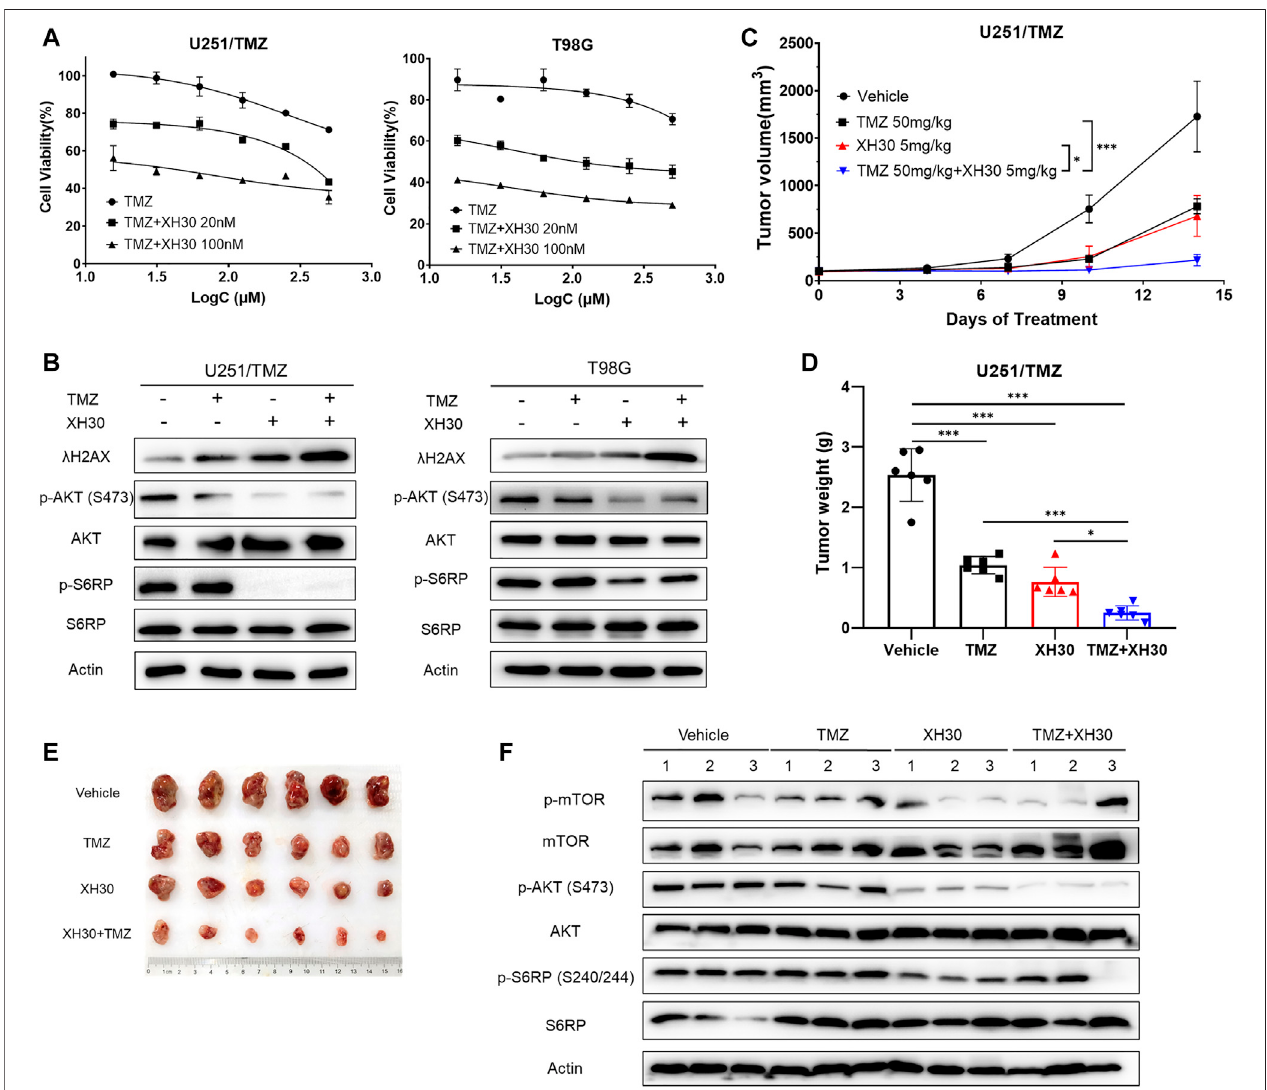
FIGURE5| XH30enhancedTMZresponseinTMZ-resistantGBM. (A) ThecurveforcombinedXH30andTMZtreatmentinGBMcellsfor72 h.Dataarepresented as means ± SD, n (cid:1) 3. (B) Combination of XH30 with TMZ increased the level of λ H2AX. Cells were incubated with XH30 (100 nM) or TMZ (250 μ M) for 12 h. (C) Antitumor activity of XH30 in an U251/TMZ subcutaneous xenograft model. t -test, * p < 0.05 and *** p < 0.001, compared with the TMZ or XH30 group. Data are presentedasmeans ± SD, n (cid:1) 6. (D) TumorweightinanU251/TMZxenograftmodel. t -test,* p < 0.05and*** p < 0.001. (E) TumorissuesinaU251/TMZxenograft model. (F) Levels of proteins in the PI3K signaling pathway in tumor tissue from the U251/TMZ xenograft mice model.